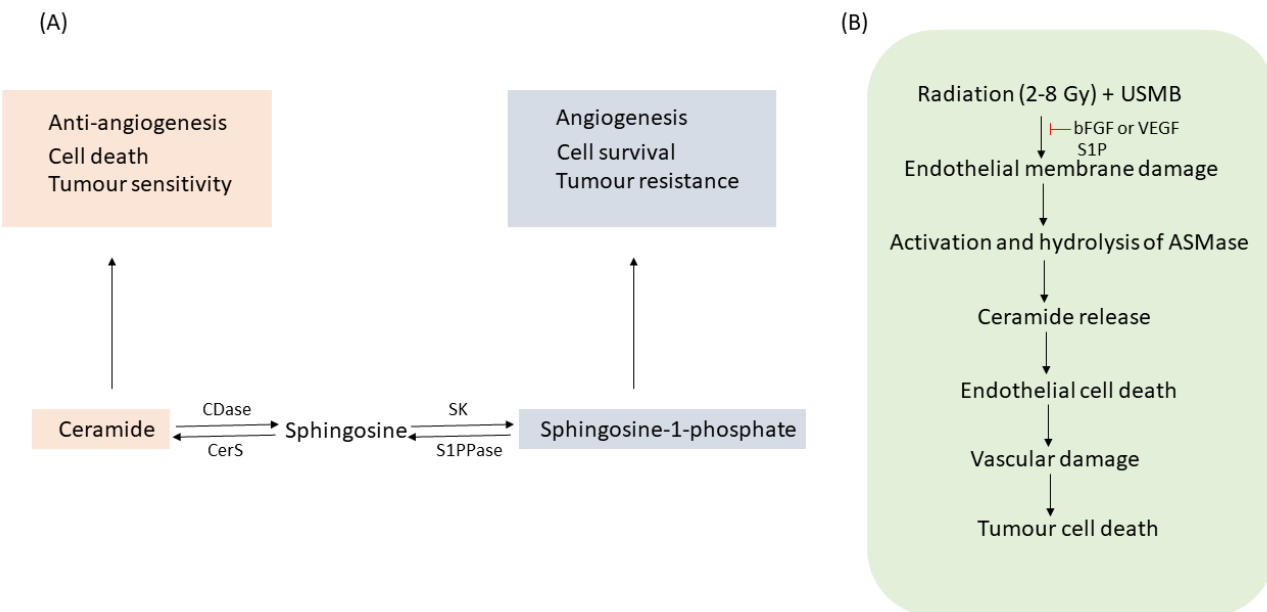
Figure 2. ( A ) The ceramide and S1P rheostat in the regulation of cell death and survival. An increase in ceramide inhibits angiogenesis, making cells sensitive to radiation therapy. On the other hand, S1P elevation causes cells to proliferate, promoting angiogenesis and resulting in resistance to radiotherapy. ( B ) Effect of radiation and USMB on tumour damage. Radiation dose (2 – 8 Gy) combined with USMB induces ASMase/ceramide activation. This leads to endothelial membrane perforation causing vasculature damage, ultimately killing tumour cells. The entire process can be abrogated using bFGF/VEGF or ceramide antagonist, S1P. Abbreviations: ASMase — acid sphingomyelinase;